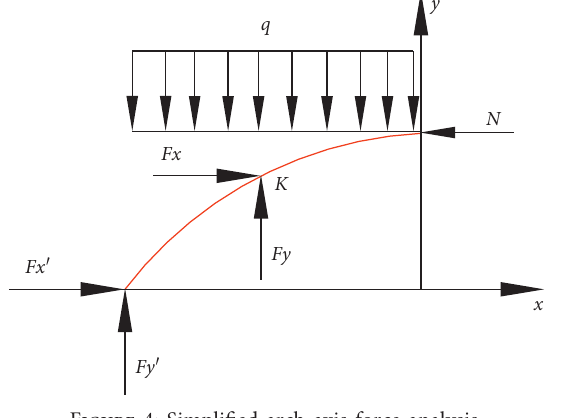
Figure 4: Simplified arch axis force analysis.